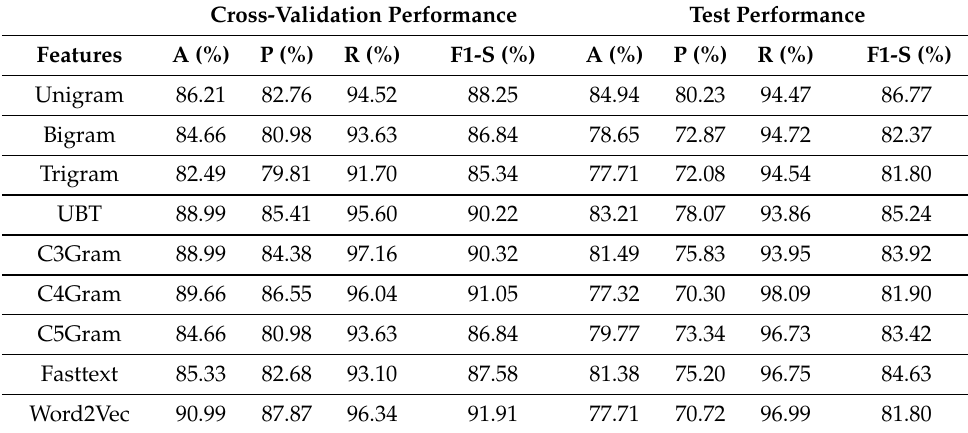
Table 9. Performance of Support Vector Machine (SVM) machine learning classifier.